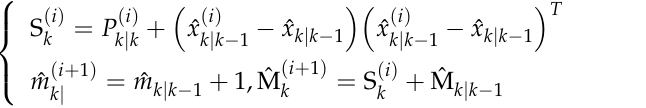
of the one- k | k − 1